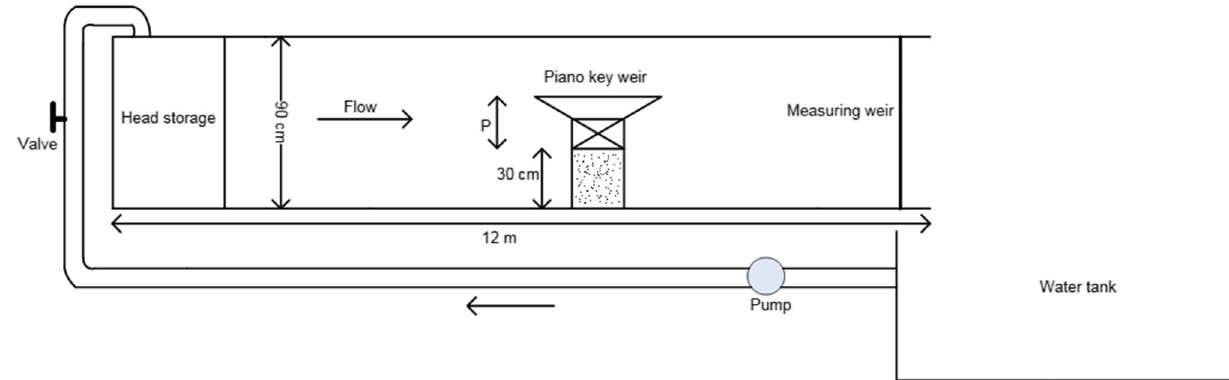
Fig. 1 Experimental scheme